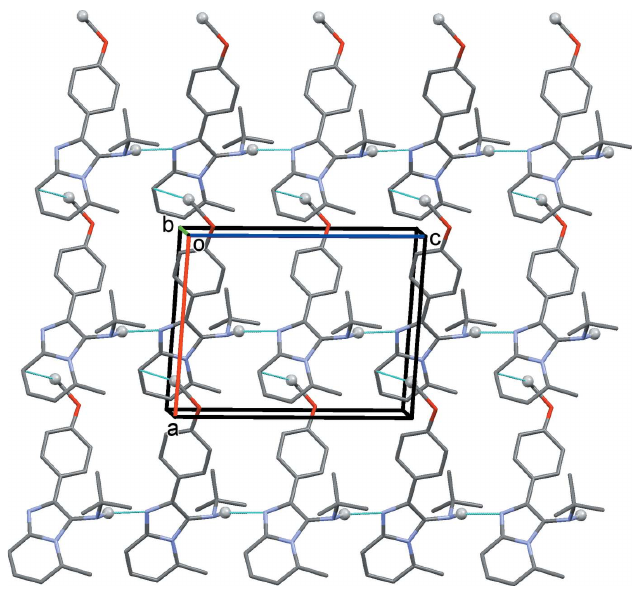
Figure 4 The crystal packing of compound (I) viewed along the b axis, showing the intermolecular N—H (cid:2)(cid:2)(cid:2) N hydrogen bonds as dashed lines (Table 1). The C—H (cid:2)(cid:2)(cid:2) (cid:2) interactions are also represented by cyan dashed lines (Table 1).